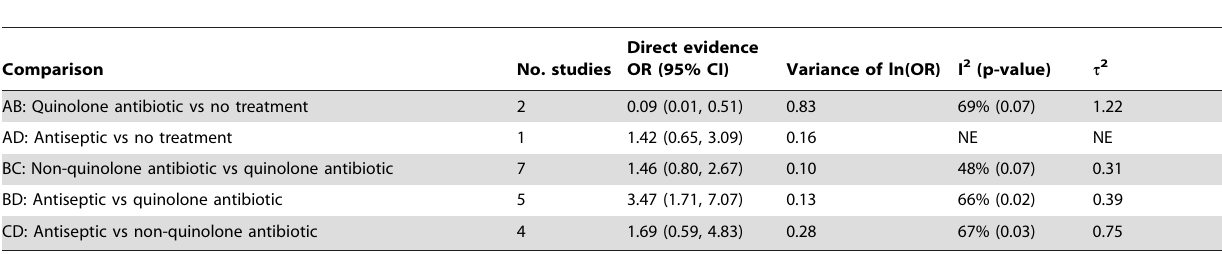
Table 1. Summary information from direct comparisons of topical antibiotics without steroids for chronically discharging ears.